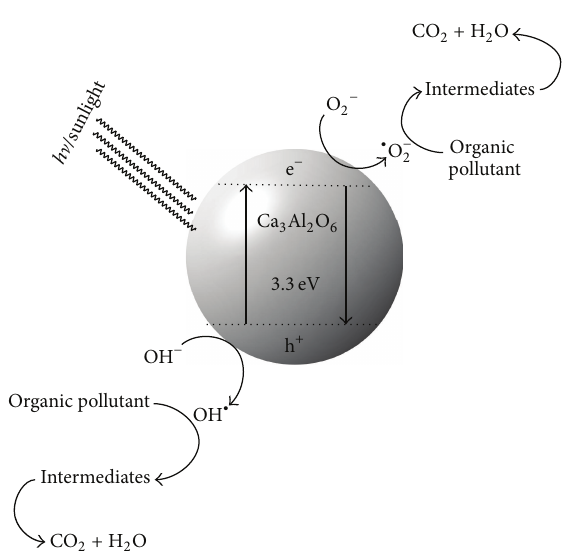
Figure 9: Mechanism of action of Al 2 O 3 ⋅ CaO